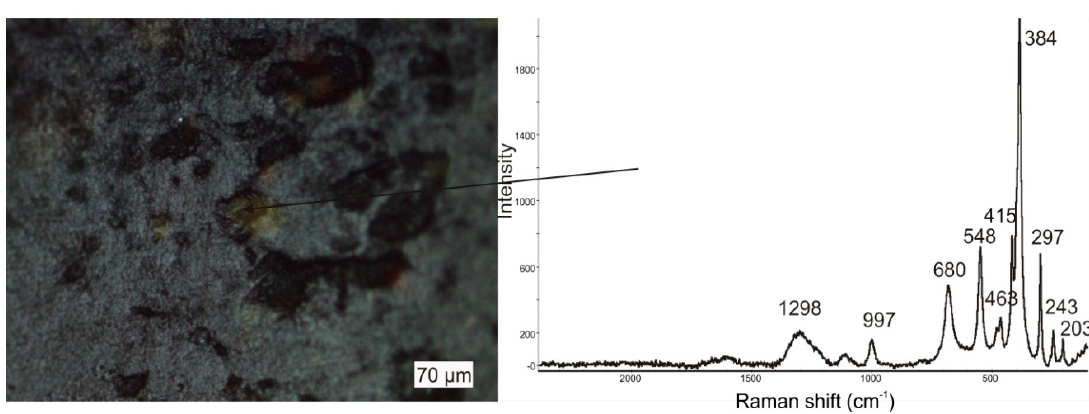
Figure 7. Microphoto of goethite in agate with its Raman spectrum.